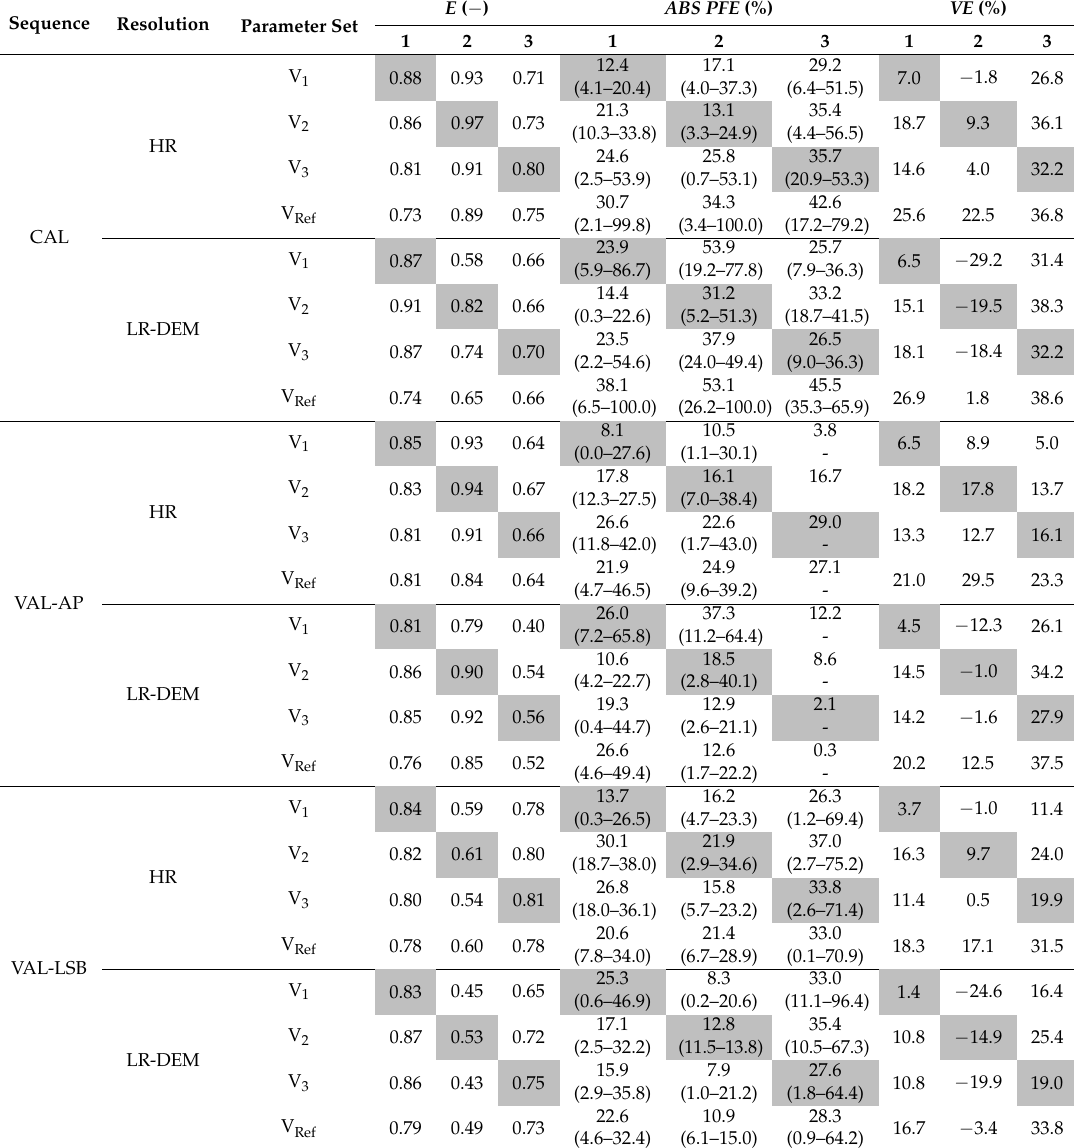
Table 6. Model performance statistics (efficiency E , absolute peak flow error ABS PFE , and volume error VE ) for the HR and LR-DEM models of the study Catchments 1, 2, and 3 for the alternative parameter sets V 1 , V 2 , V 3 , and V Ref and the three studied sequences of events. Performance statistics with a grey background were produced by the parameter set specifically calibrated to the study catchment. ABS PFE in the first row of each parameter set represents the mean value for the sequence events while the values given in parentheses represent the range of ABS PFE